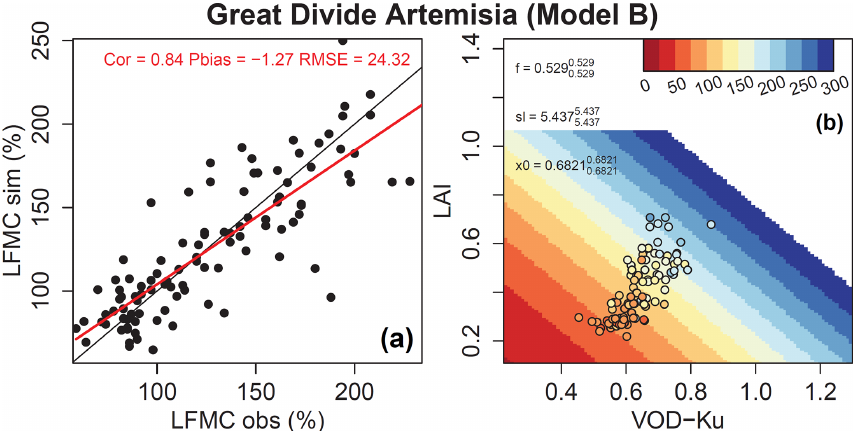
Figure 4. Example of the fit of Model B using daily Ku-VOD and monthly LAI for Artemisia tridentata ssp. at the site Great Divide, Colorado (40.76 ◦ N, 107.85 ◦ W). (a) Scatterplot of estimated against observed LFMC. (b) Distribution of observed LFMC (points) and estimated LFMC (coloured background) in relation to daily Ku-VOD and monthly LAI.